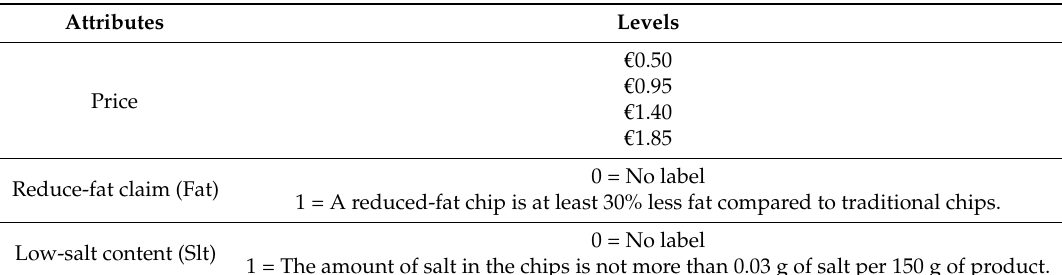
Table 1. Attributes and levels used in the choice experiment design.